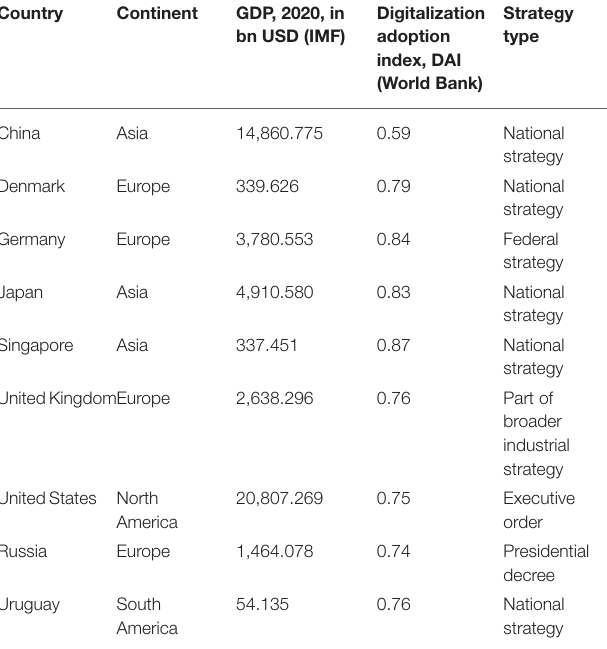
TABLE 1 | Selection of criteria.